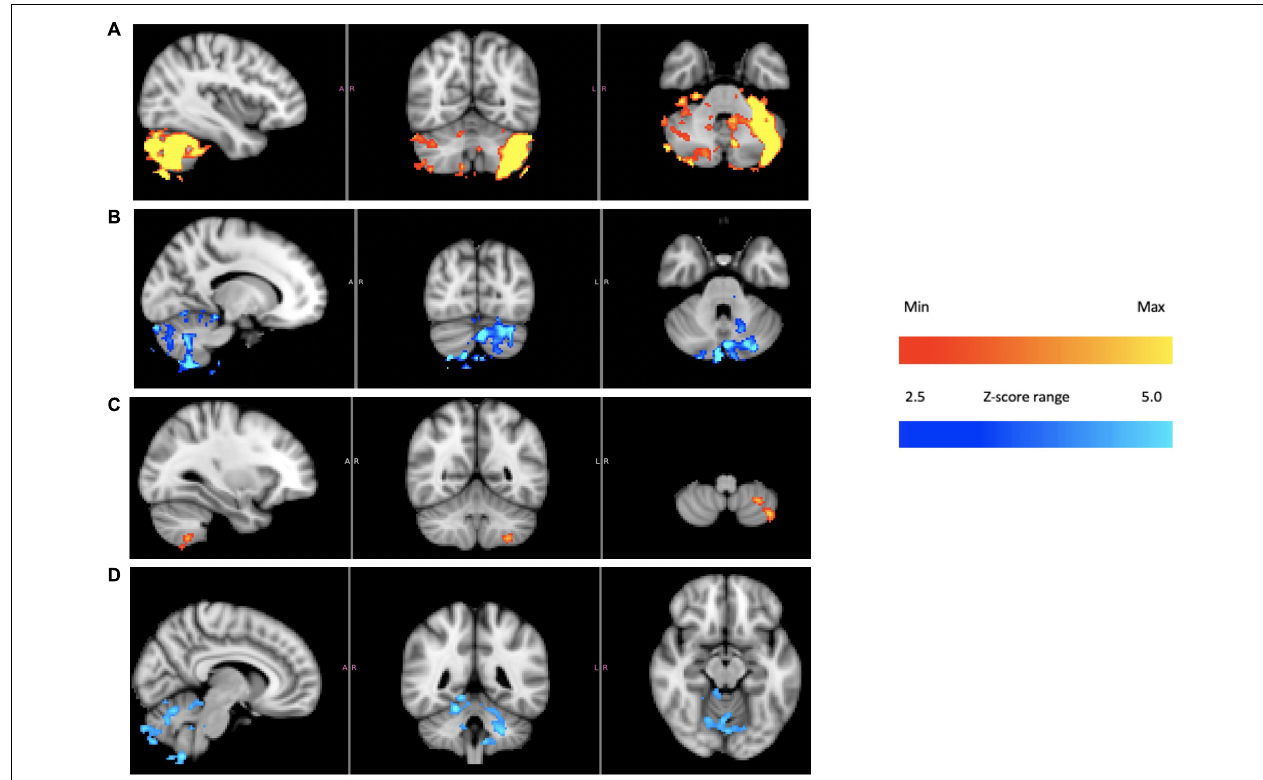
FIGURE 5 | Cerebellum of subject 4 [ (A) plateaus dominant, (B) troughs dominant]; cerebellum of subjects 1–3 averaged together [ (C) plateaus dominant, (D) troughs dominant]. The color bars show relative z-score values. The orange/red and blue/aqua color bars are not related to each